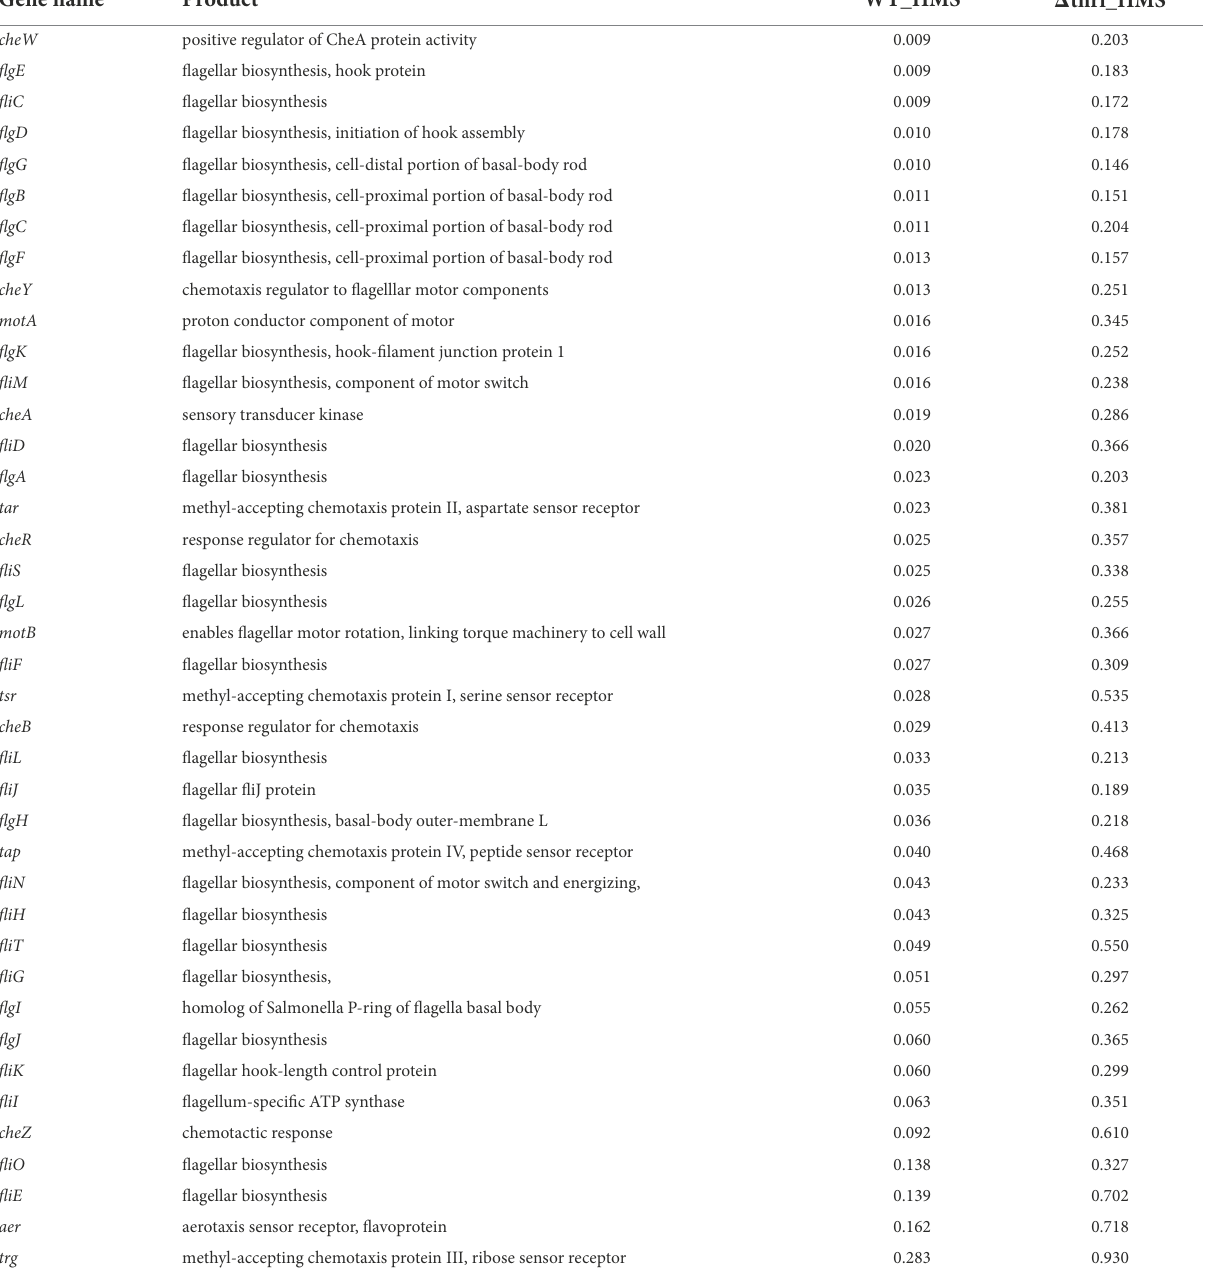
TABLE 4 List of genes that belong to the locomotion-chemotaxis-motility process that were downregulated in WT and Δ thrL mutant in response to